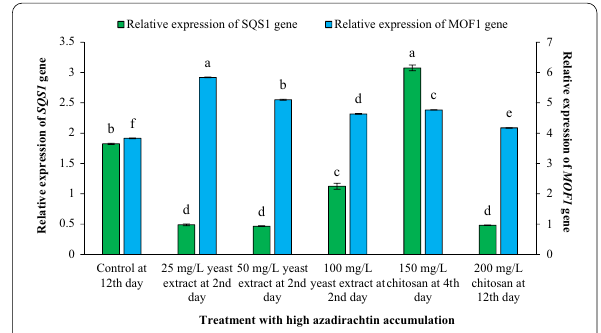
Fig. 5 Relative expression profile of SQS1 and MOF1 genes normalized with 18S ribosomal RNA as an internal